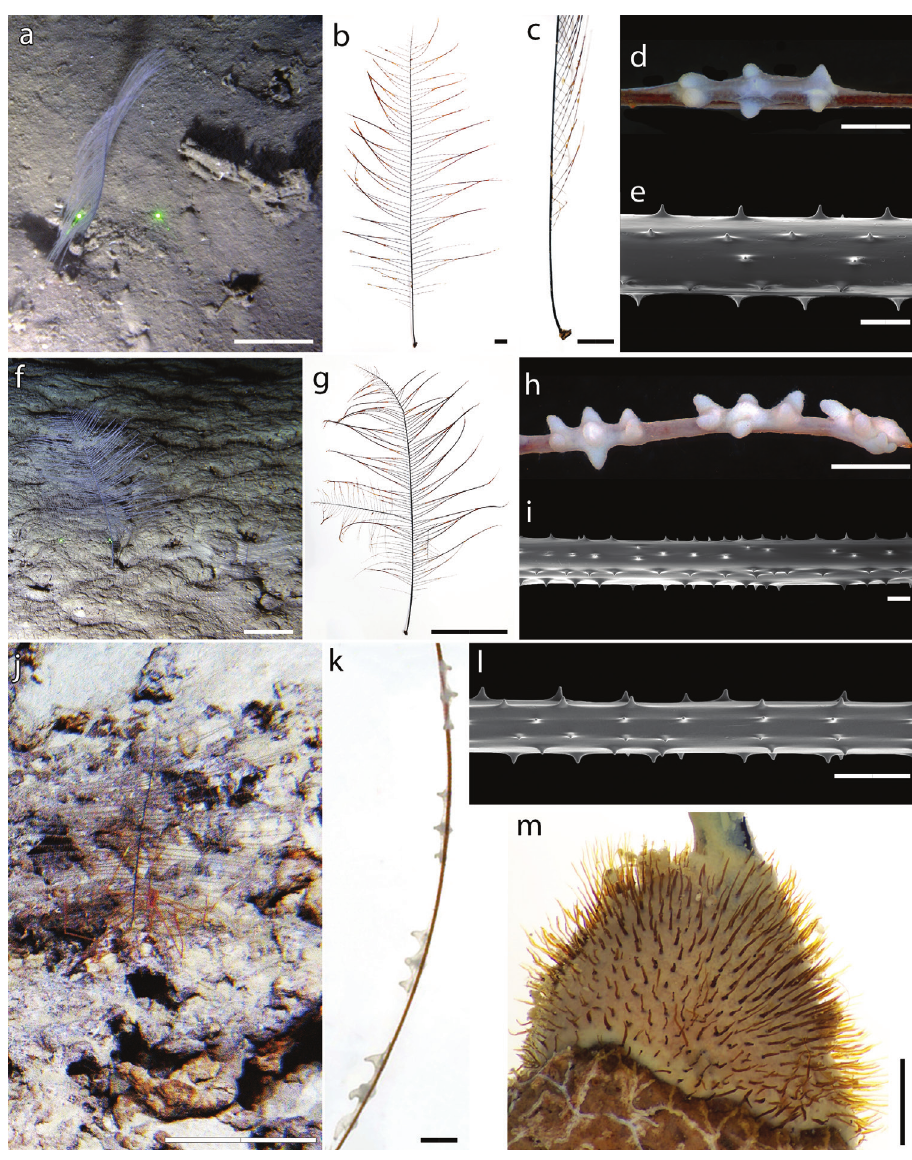
Figure 5. Paratypes of Bathypathes thermophila sp. nov. KAUST-NTN0037-8 a colony in situ, on a muddy bottom with scattered biogenic hard substrate b dry colony in frontal view (polypar side) and in c lateral view d polyp e spines on a proximal pinnule. MUZAC-6665 f colony in situ on muddy bottom g dry colony in frontal view h distal polyps i proximal spines on a pinnule from the lower part of the corallum. MUZAC-6666 j colony in situ on a hard ground, with a spider crab as epibiont k polyps on pinnule l spines arrangement on pinnule form the upper part of the corallum m base of the colony. Upper side of horizontal skeletal elements is the polypar side. Scale bars: 10 cm ( a, f, g, j ); 1 cm ( b, c ); 1 mm ( d, h, k, m ); 100 μm ( e, i, l